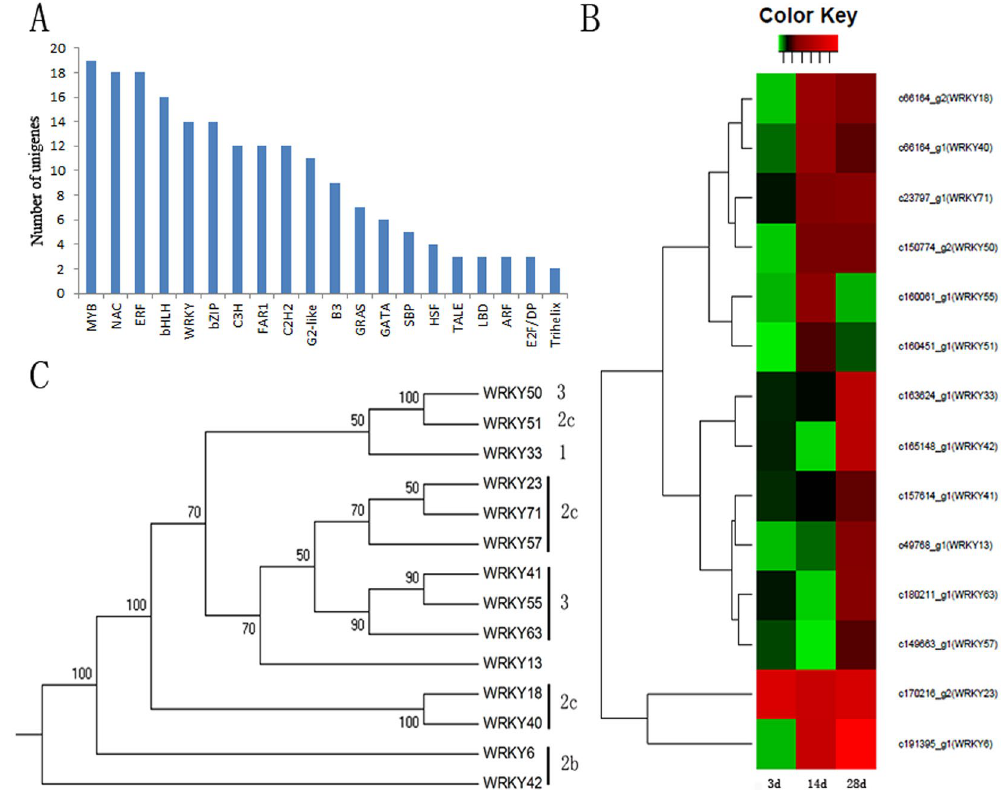
Figure 7. Comparison of DEGs between Cm and cucumber after 14 RKN treatment. The KOG analysis and comparison between cucumber and Cm . The x-axis indicates clusters arranged by KOG. The y-axis indicates the number of the KOG clusters. Blue columns represent Cm and red columns represent cucumber. * Indicate very significant difference between cucumber and Cm (p <